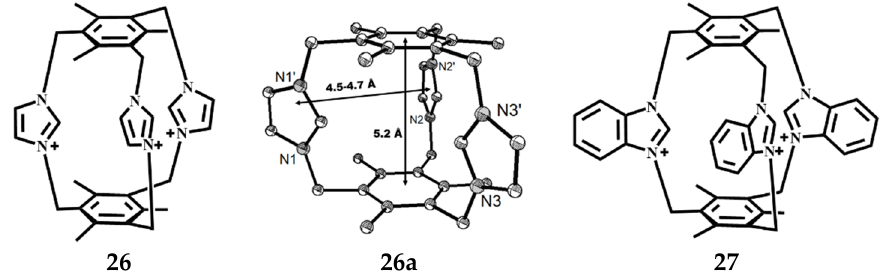
Figure 15. The structures of cyclophanes 26 and 27 and ORTEP drawings of complex 26 (the probability of thermal ellipsoid is